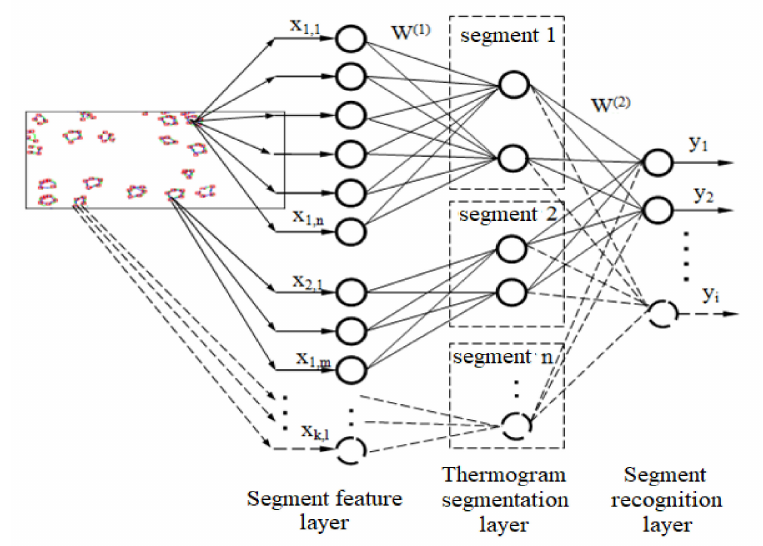
Figure 8. The structure of a multi-segment neural network for segmentation and recognition of the thermogram of a steel ladle.